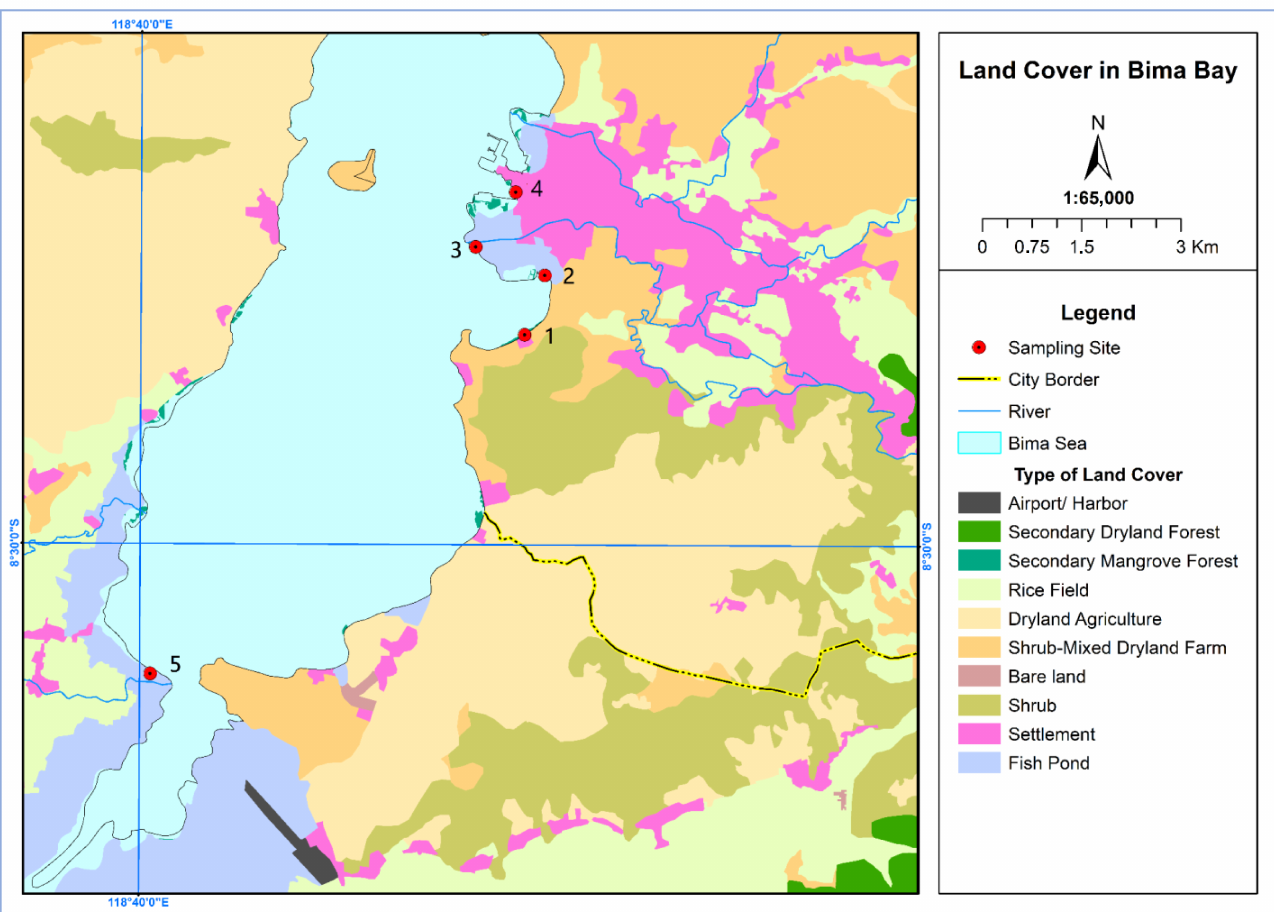
Figure 6. Map of the five sampling locations in Bima City